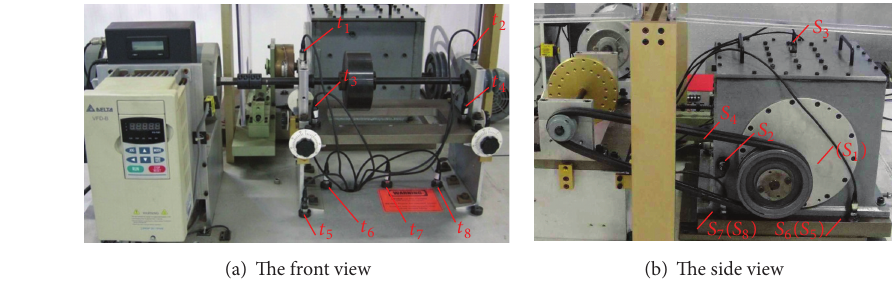
Figure 2: The machinery fault simulator.